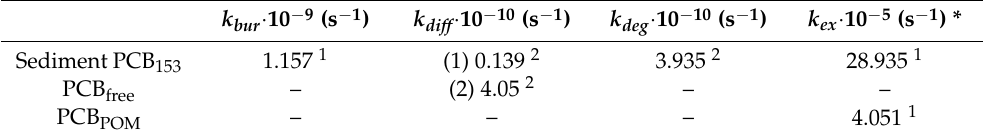
Table 4. Rate constants, used in modeling PCB 153